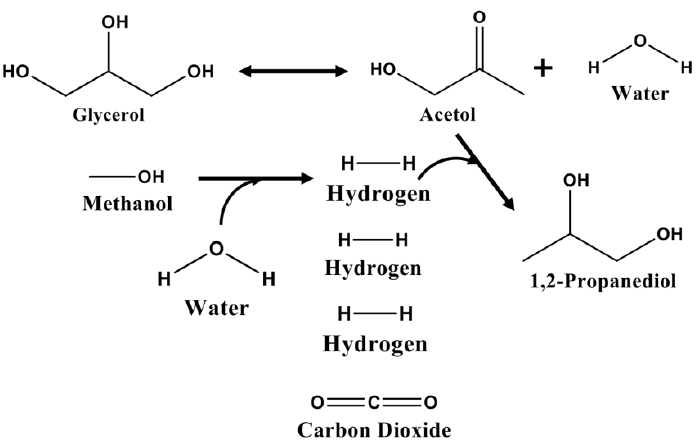
Scheme 1. Reaction pathway of glycerol hydrogenolysis to produce 1,2-PD with in situ hydrogen produced from methanol steam reforming .